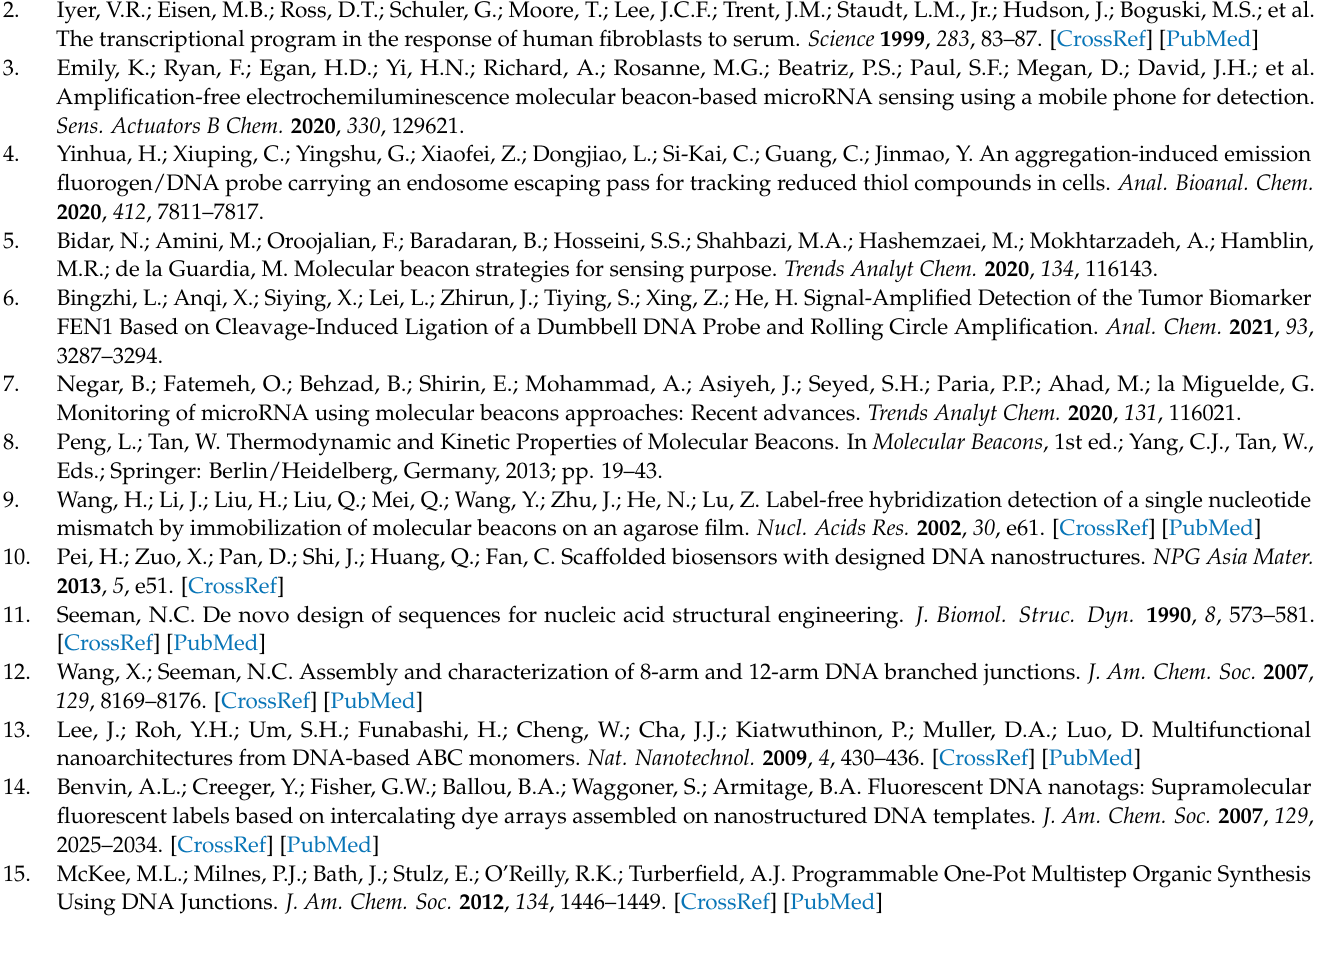
Table of Contents Graphic: The bead-immobilized multimodular molecular beacon-equipped